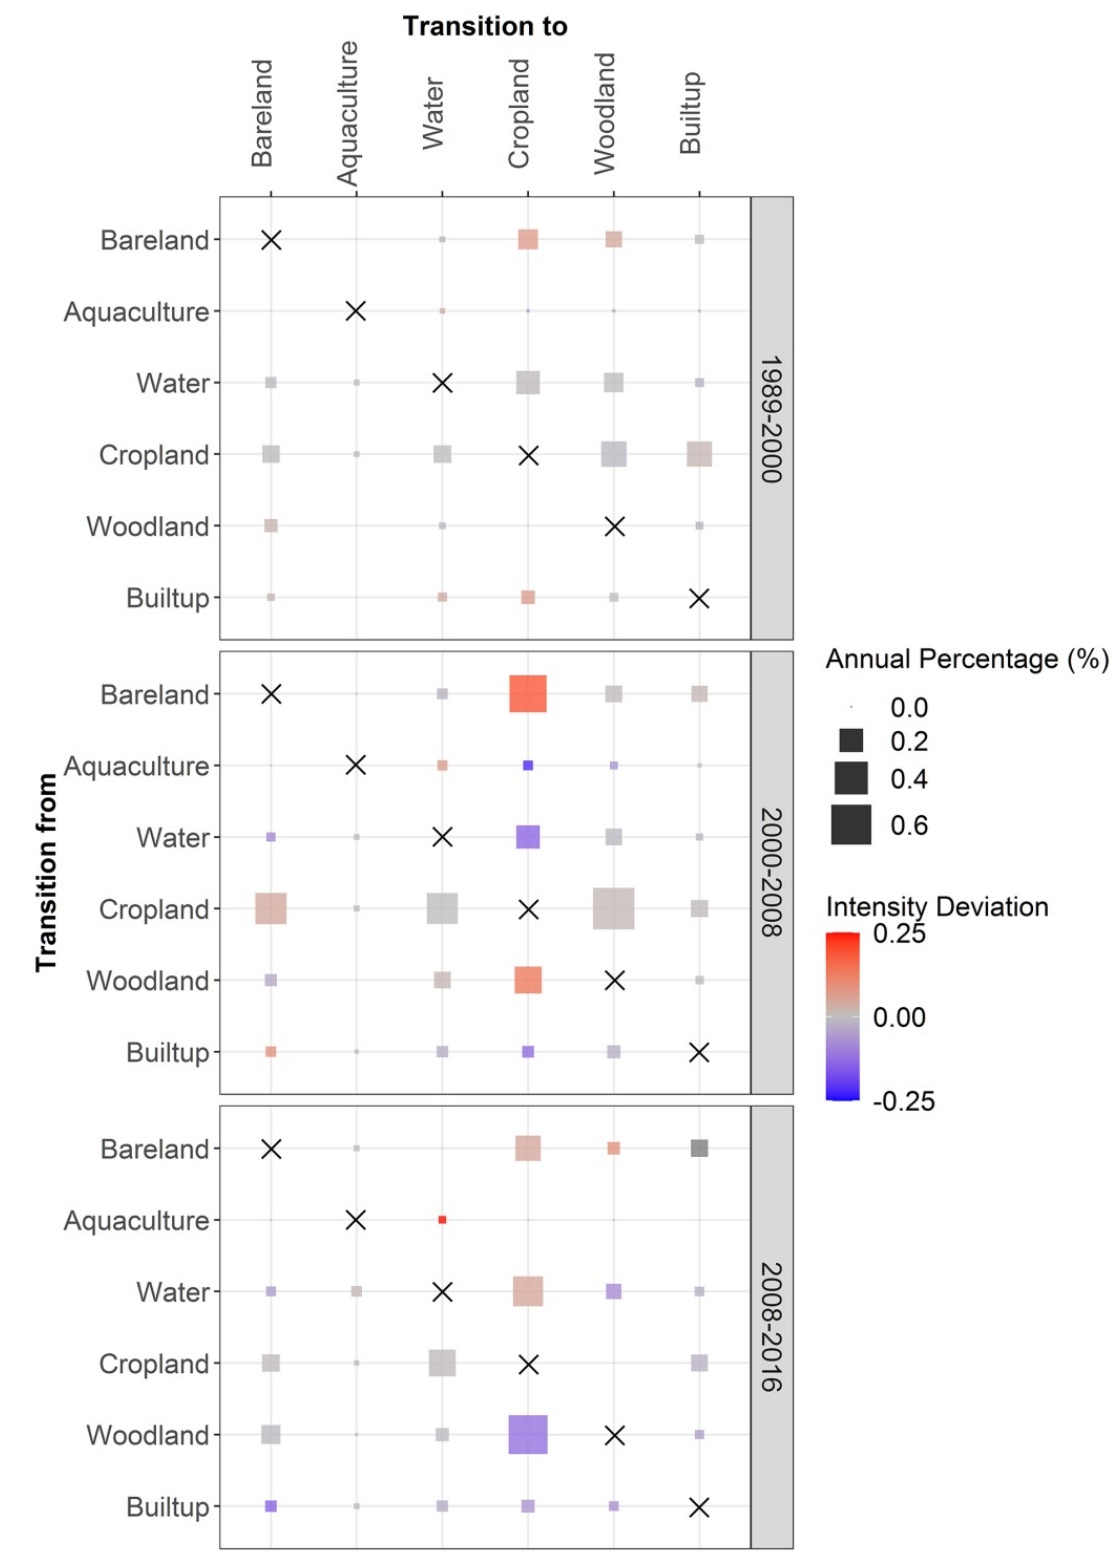
Figure 11. Transition patterns for three time intervals. Each square’s size indicates the transition’s size. The gradient of colors indicates the deviation between the transition intensity and the column’s uniform transition intensity. Intensity Deviation = R tij − W tj . Red means targeting and blue means avoiding.